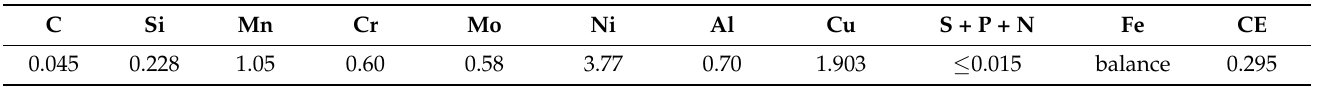
Table 1. Chemical composition of the UHS experimental steel